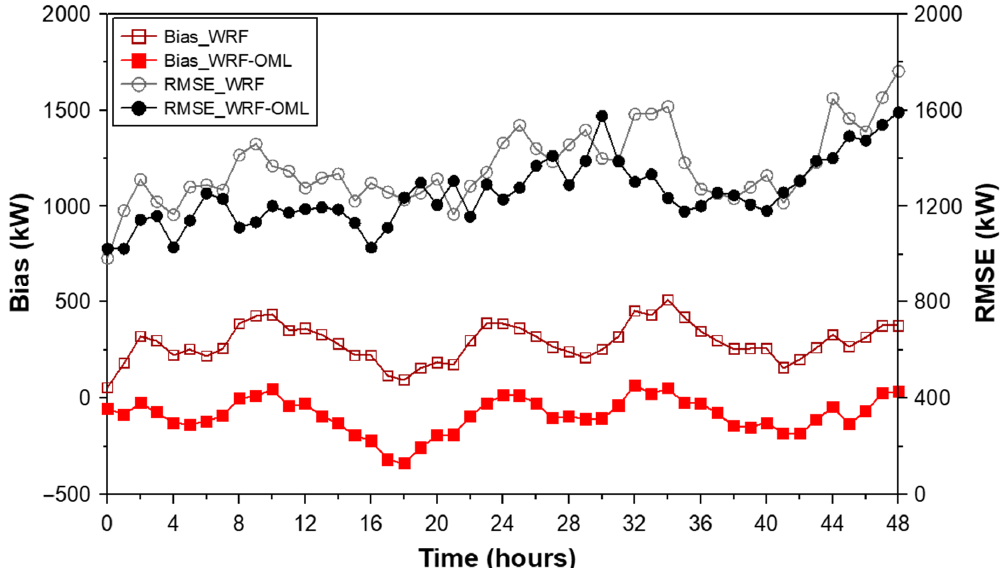
Figure 11. Bias and RMSE of simulated results using WRF and WRF-OML (power production at 94-m height) models with prediction time.